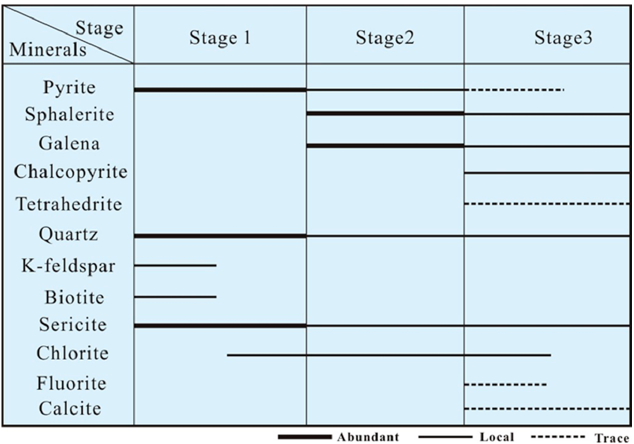
Figure 5. Mineral parageneses at the Xiajinbao Au deposit.